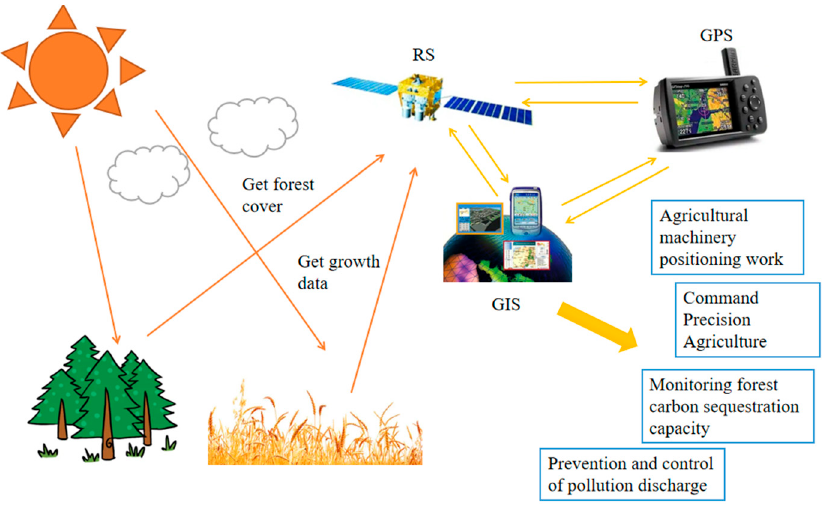
Figure 2. The implementation path of “3S” technology to help agricultural carbon reduction and carbon